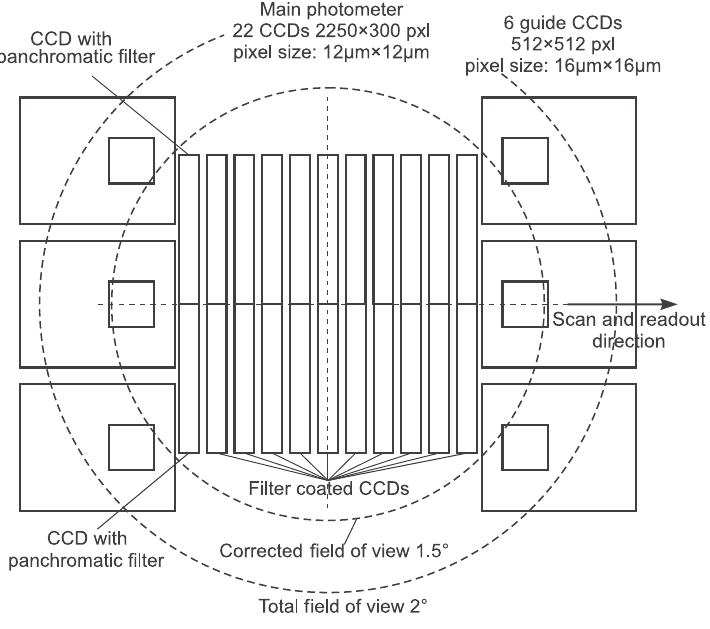
Fig. 1. The focal plane of the “Lyra-B”